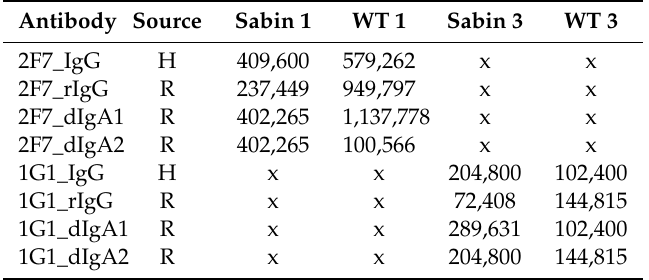
Table 2. Poliovirus neutralizing activities of the recombinant IgA